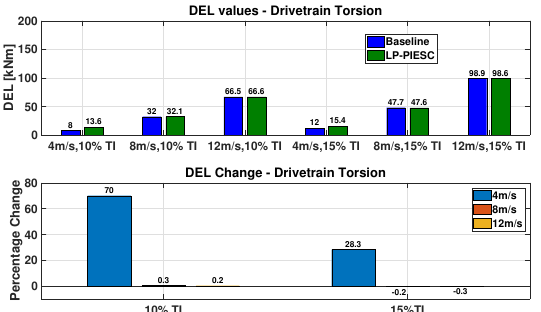
Figure 13. Drivetrain torsion comparison: Baseline vs. LP-PIESC. Aggregate DEL values with baseline controller and LP-PIESC ( top ), percentage change in DEL ( bottom ) for time series from 150 s to 3000